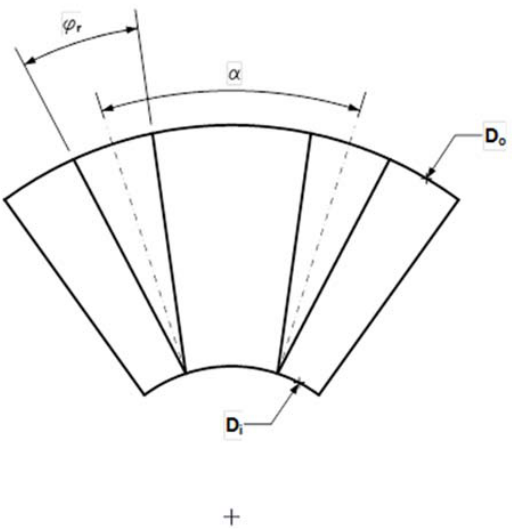
Figure 7. Rotor section showing disposition and dimensions of rotor poles.